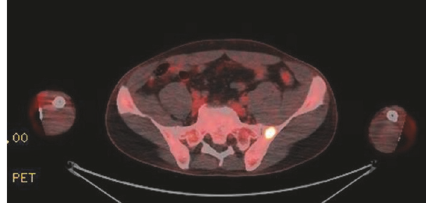
Figure 3: FDG avid lesion in left iliac bone.